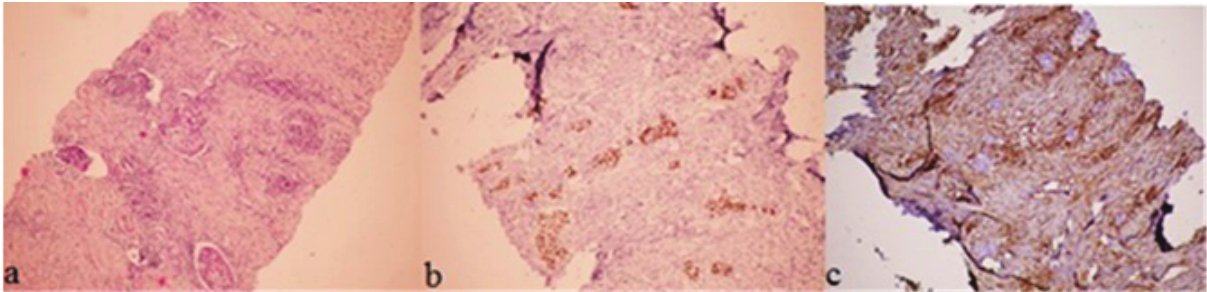
Figure 4: Pathological view of the tumor cells. (a) Hematoxylin and eosin staining showing island formation of tumor cells in the inflamm- atory stroma. (b) Nuclear staining with p63 antibodies (100x). (c) No staining with vimentin antibodies (100x).